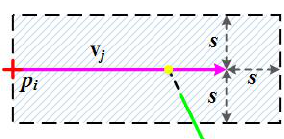
Figure 3. Salient point computation in the direction of one vector of LGS. The red cross denotes an interest point purple arrow denotes a vector line is a straight line dropping in the impact zone of yellow solid dot is a salient point in the direction of